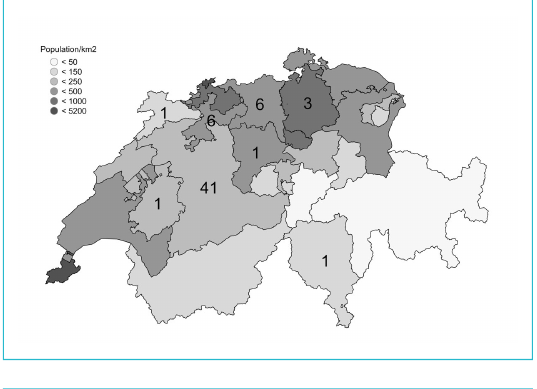
Figure 1a: Cantons of Switzerland and their populations per km 2 (grey), with the number of patients with Behçet’s syndrome per canton.